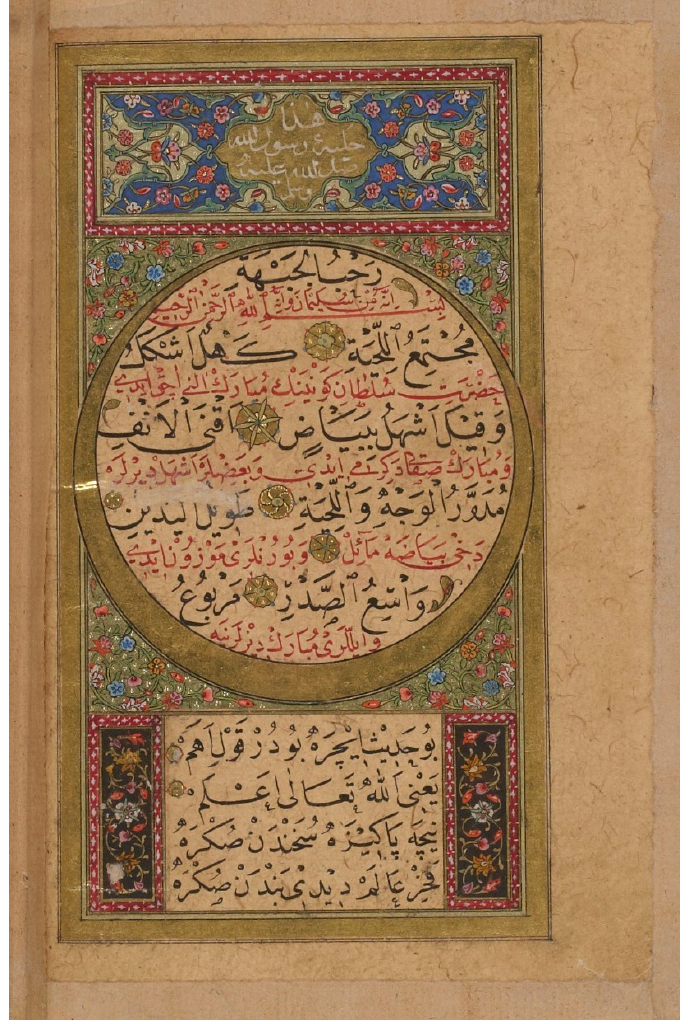
Figure 3. A h. ilye-i ¸ser¯ıf , with Ottoman Turkish interlinear translation, completed by by Ism¯a’¯ıl Bagd¯ad¯ı in Figure 3. A ḥ ilye-i ş er ī f , with Ottoman Turkish interlinear translation, completed by by Ism ā ʿ ī l Bagd ā d ī 1756 / 57, added to a somewhat earlier copy of the Dal¯a’il . Biblioth è que nationale de France, D é partement in 1756/57, added to a somewhat earlier copy of the Dal ā ’il . Bibliothèque nationale de France, des manuscrits, Arabe 6859 i., folio Département des manuscrits, Arabe 6859 i., folio 5v.